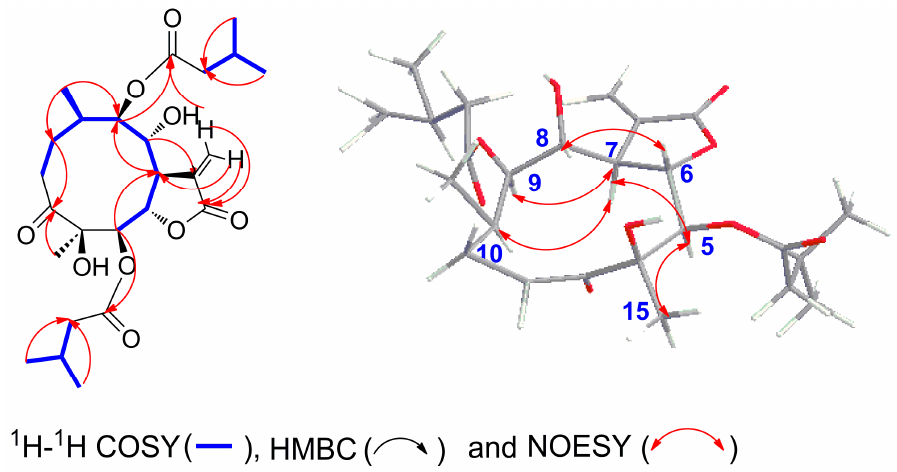
Figure 4. Key 2D correlations of compound 2 .